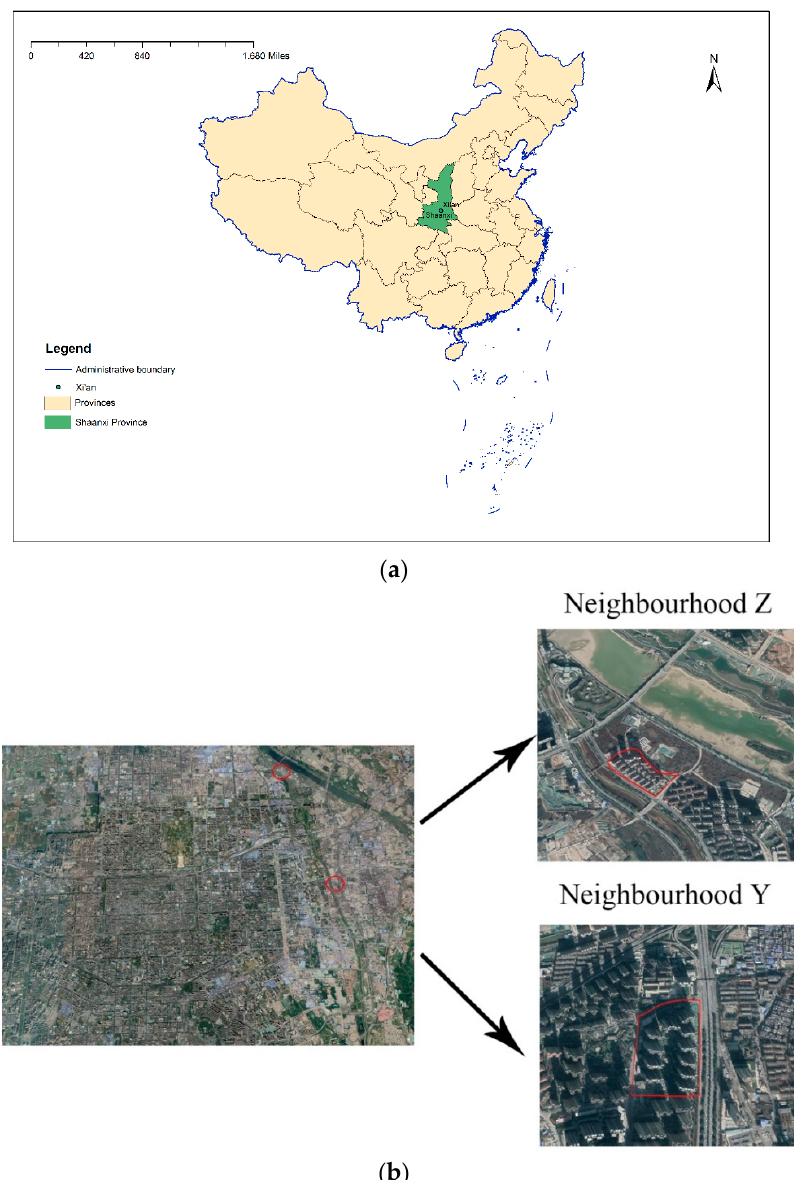
Figure 2. The study area map. ( a ) The location of Xi’an; and ( b ) locations of neighbourhoods Y and Z.